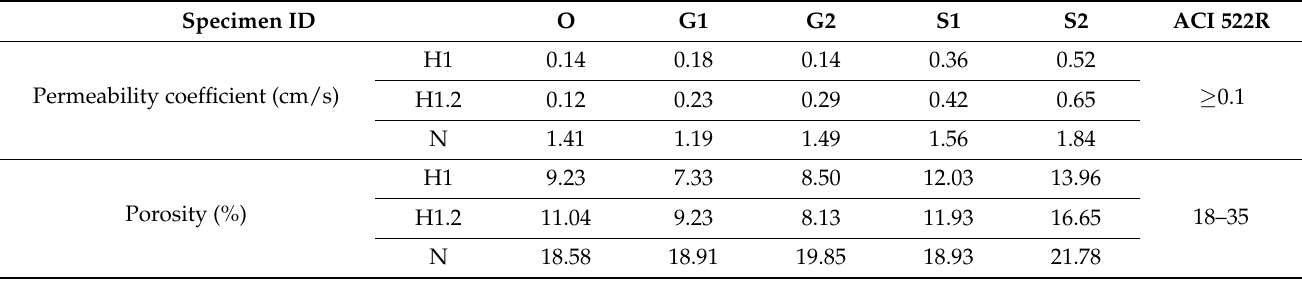
Table 5. Results for porosity and permeability coefficient